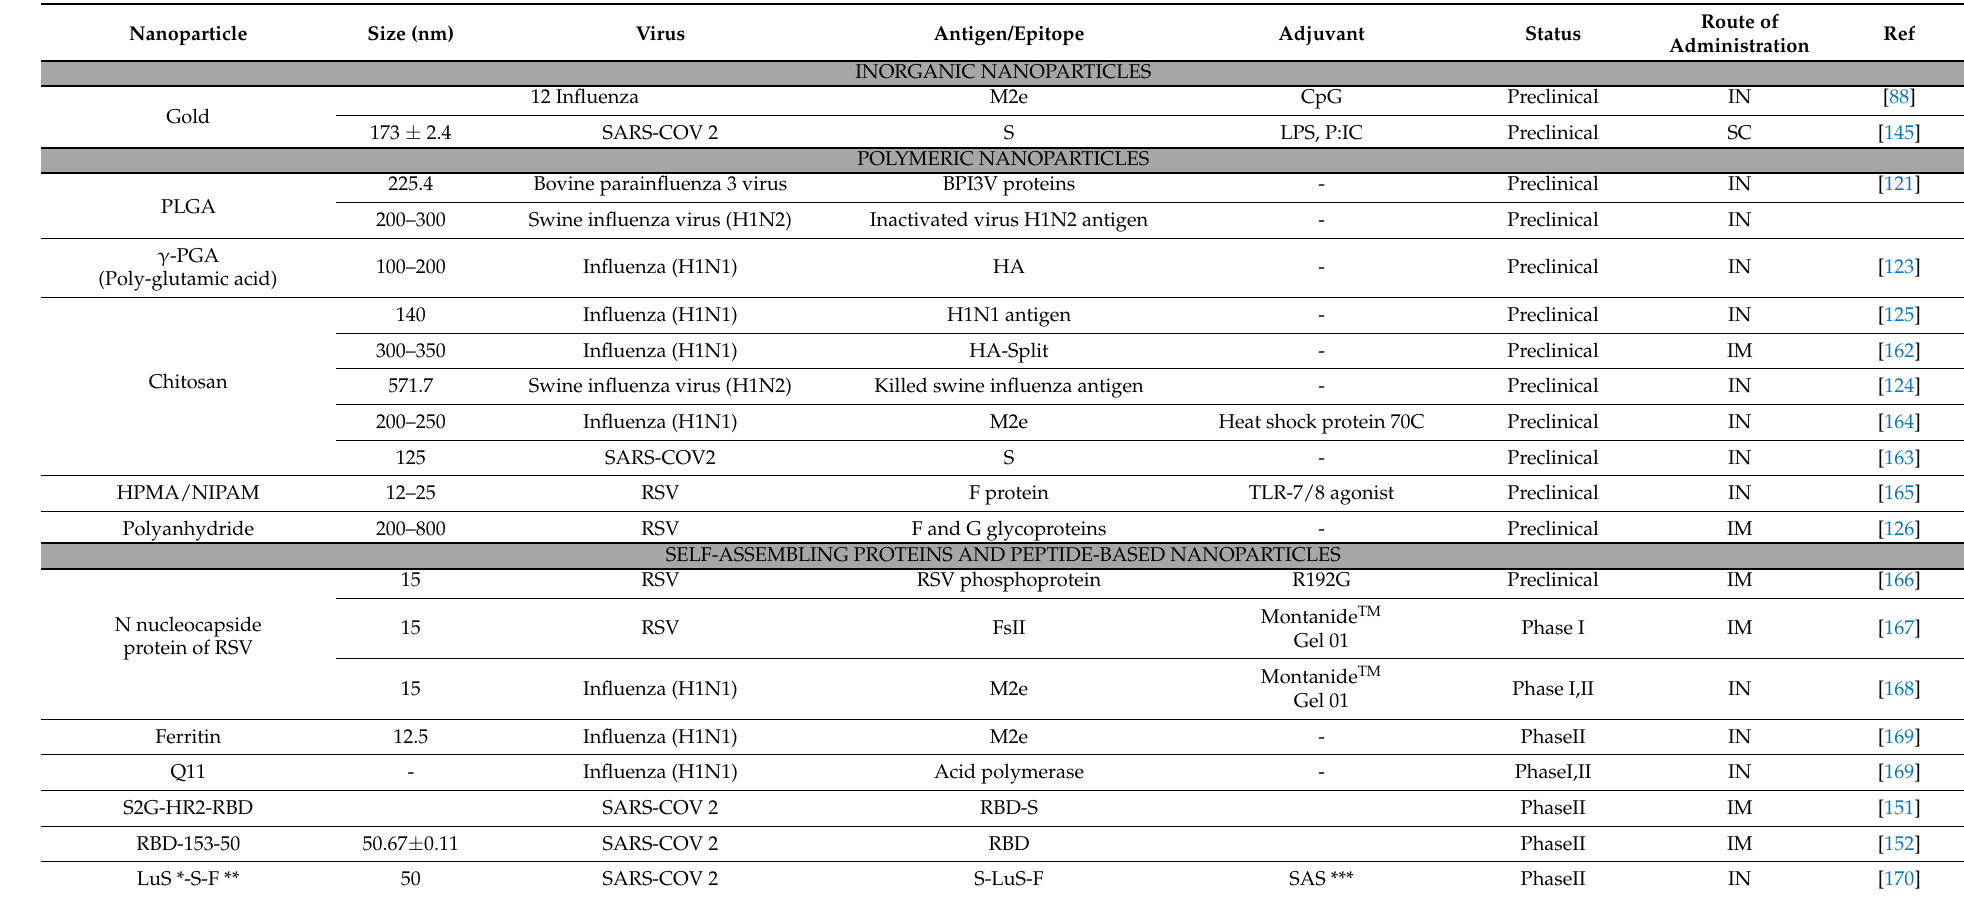
Table 2. Nanoparticle-based vaccine formulations against respiratory virus